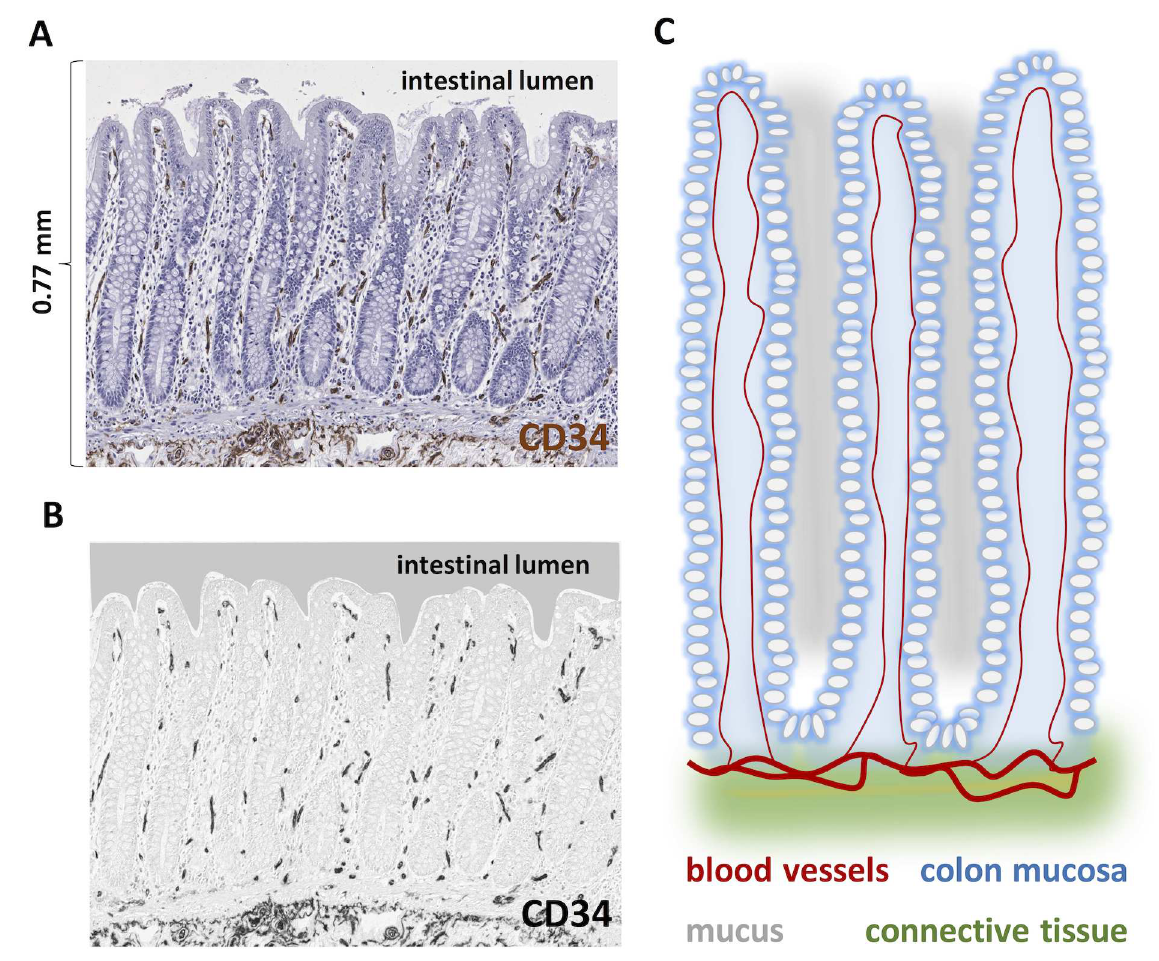
Fig 8. Physiological blood vessel distribution in colon mucosa. Blood vessel architecture in normal colon mucosa where blood vessels run along the crypt wall at the barrier to the intestinallumen. (A) Original CD34-stained image. This image is representative of five independent whole slide images. (B) For better clarity, the originalimage was processedby color deconvolution and only the CD34-staining is shown. (C) Schematicillustrationof the physiological blood vessel architecture in colon mucosa. A blood vessel runs closely to the surface betweentwo adjacent